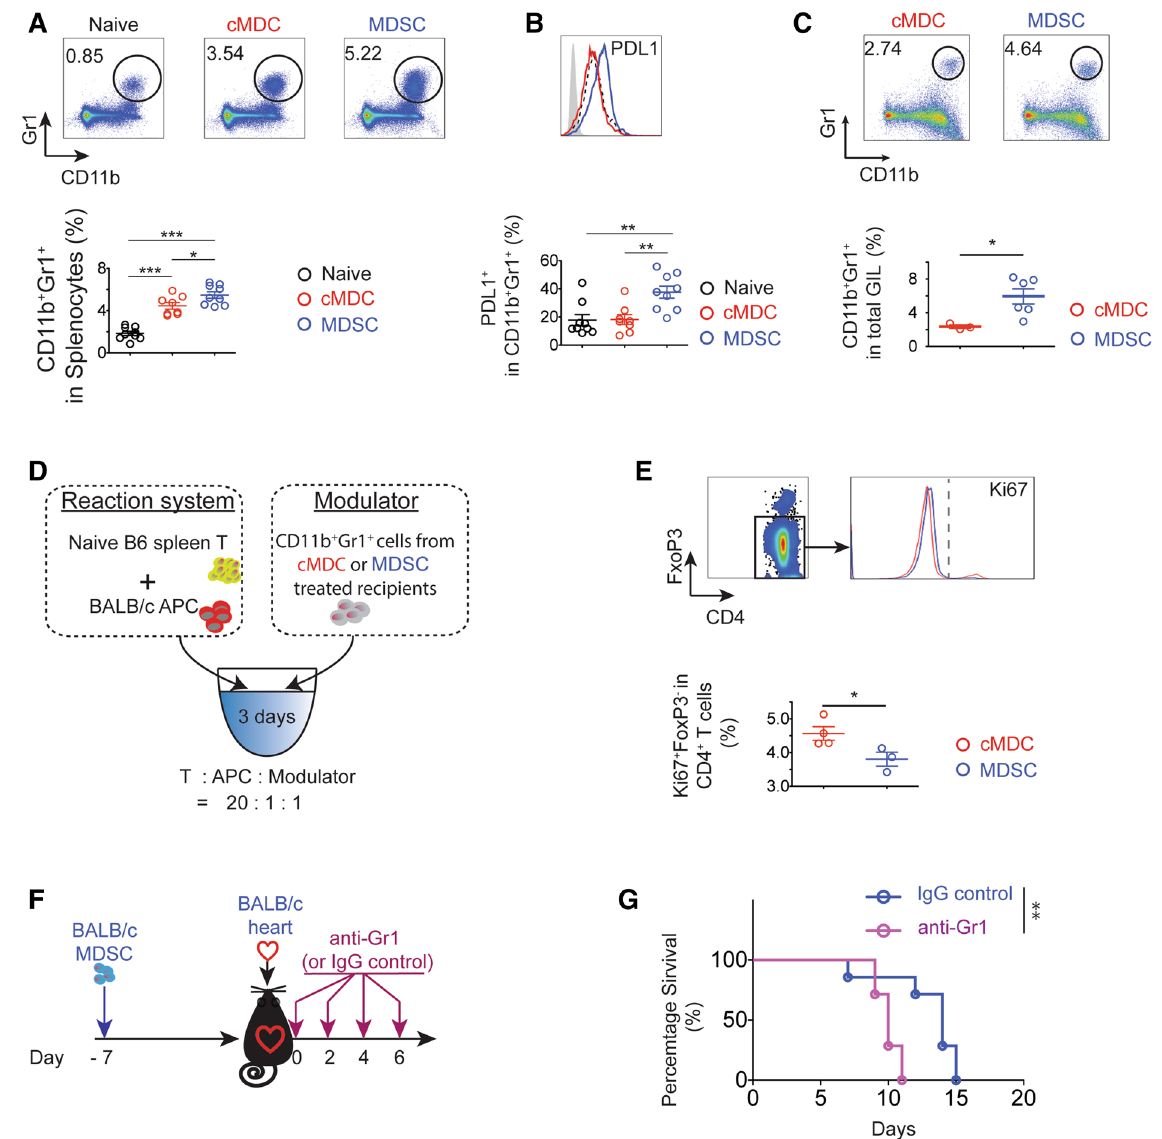
Figure 4. Endogenous MDSCs (CD11b + Gr1 + ) are essential to donor-derived MDSCs mediated alloimmune suppression. ( A , B ) Flow cytometry analysis of BALB/c MDSCs treated C57BL/6 recipients’ splenocytes on POD7 (n = 8–9 per group). ( A ) The proportion of CD11b + Gr1 + significantly increased in donor-derived the MDSCs treated group. ( B ) Cells were gated on CD11b + Gr1 + , PDL1 expression was up-regulated in the MDSCs treated group. Mean ± SEM, * p < 0.05, ** p < 0.01, *** p < 0.001, one-way ANOVA and Tukey’s test. Data represents one of 4 separate experiments. ( C ) Flow cytometry analysis of BALB/c MDSCs treated C57BL/6 recipients’ graft infiltration lymphocytes (GILs) on POD7. CD11b + Gr1 + population was significantly increased in MDSCs treated group. n = 3–6 per group. Mean ± SEM. Data represents one of 3 separate experiments. *p < 0.05, two-tailed unpaired t test. ( D ) Schematic illustration of the experimental design to test the ex vivo immunosuppressive function of BALB/c MDSCs induced endogenous MDSCs (CD11b + Gr1 + ) in recipients. Naïve C57BL/6 T cells were stimulated with BALB/c APCs for 3 days. CD11b + Gr1 + cells were isolated by fluorescence activated cell sorting (FACS) from C57BL/6 recipient splenocytes at POD7 (n = 3–4 per group) and were added as modulator. ( E ) Cells were gated on CD4 + FoxP3 - , and the Ki67 expression was measured. Graphs showing significant decrease of the proportion of Ki67 + FoxP3 - in CD4 + T cells in the presence of CD11b + Gr1 + cells induced with MDSCs compared to those induced with cMDCs. Mean ± SEM, * p < 0.05, two-tailed unpaired t test. Data represents one of 3 separate experiments. ( F ) Schematic illustration of the treatment protocol. C57BL/6 recipients received a single-dose intravenous injection of 1 × 10 6 BALB/c 7 days prior to the transplantation. Recipients were treated with anti-Gr1 mAb on POD 0, 2, 4, 6. ( G ) Anti-Gr1 mAb administration attenuates MDSCs induced immune suppression. Kaplan–Meier cumulative survival of allograft showing the shortened allograft survival in the anti-Gr1 Ab treated group compared to the IgG treated control group (n = 7 per group). **p < 0.01, log-rank